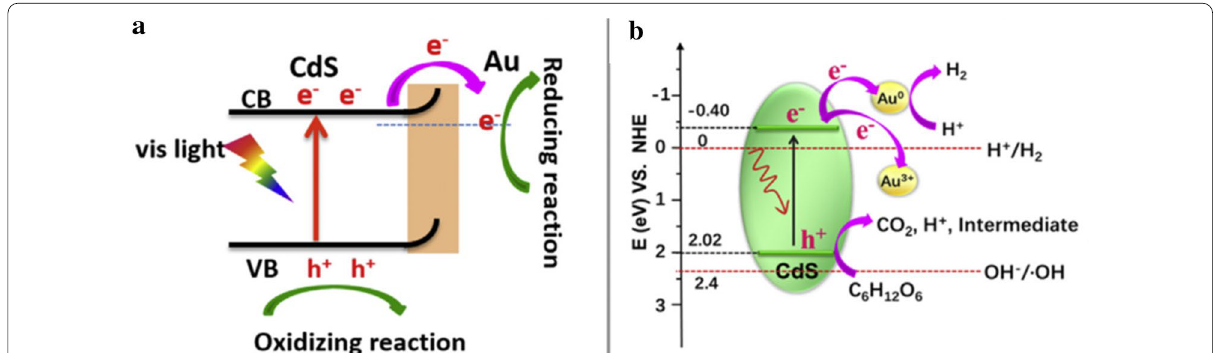
Fig. 6 The schematic band diagram ( a ) and proposed mechanism ( b ) for photocatalytic hydrogen production with Au/CdS NRs in glucose solution under visible light irradiation. Reprinted with the permission from Wang et al. [8] (Copyright 2020